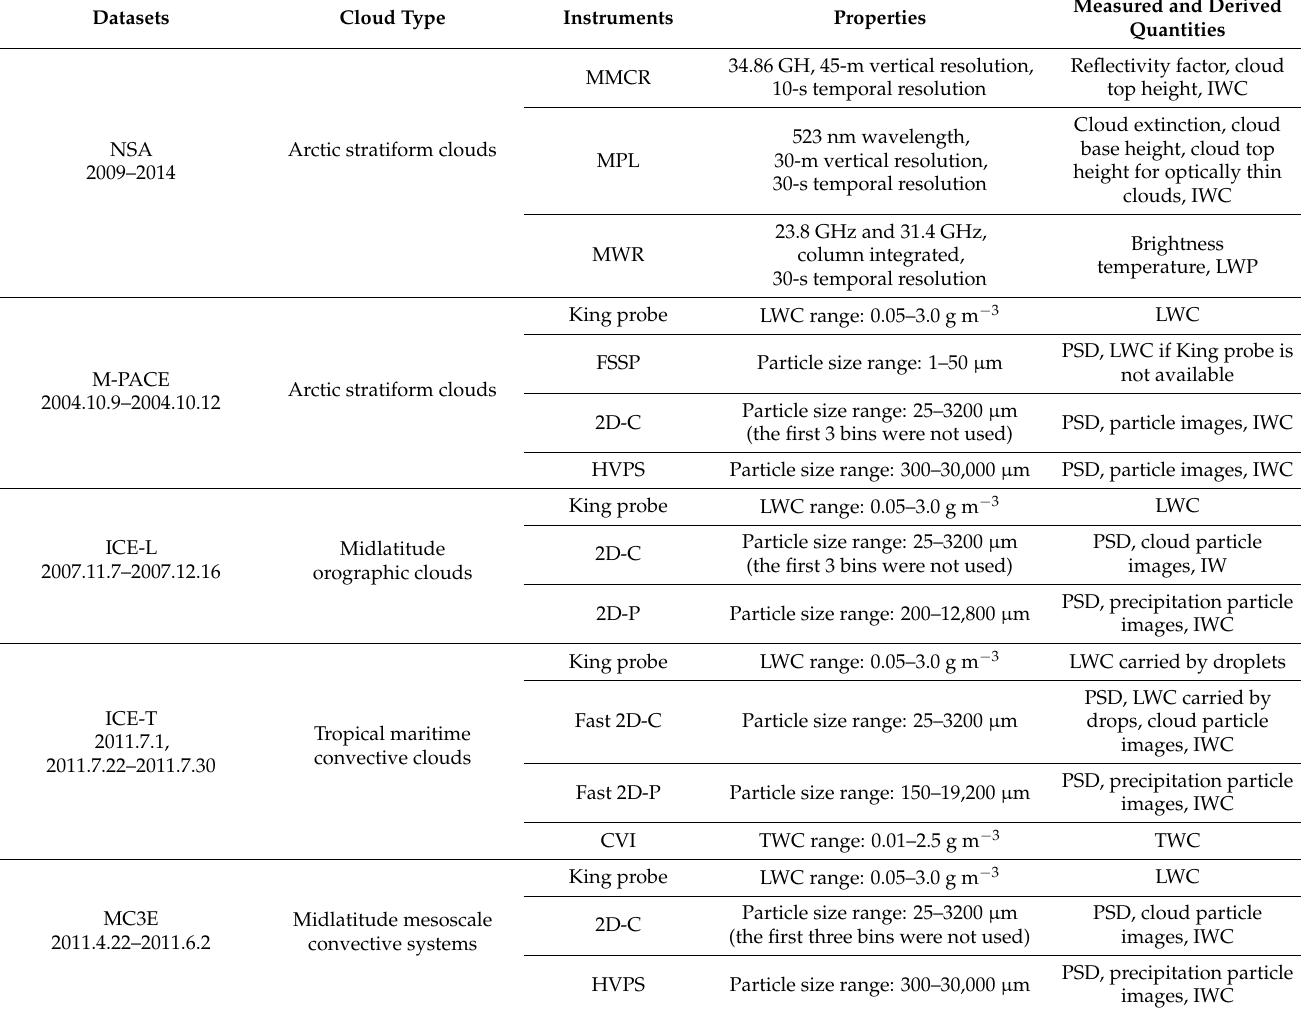
Table 1. Description of datasets, instruments, and measured and derived